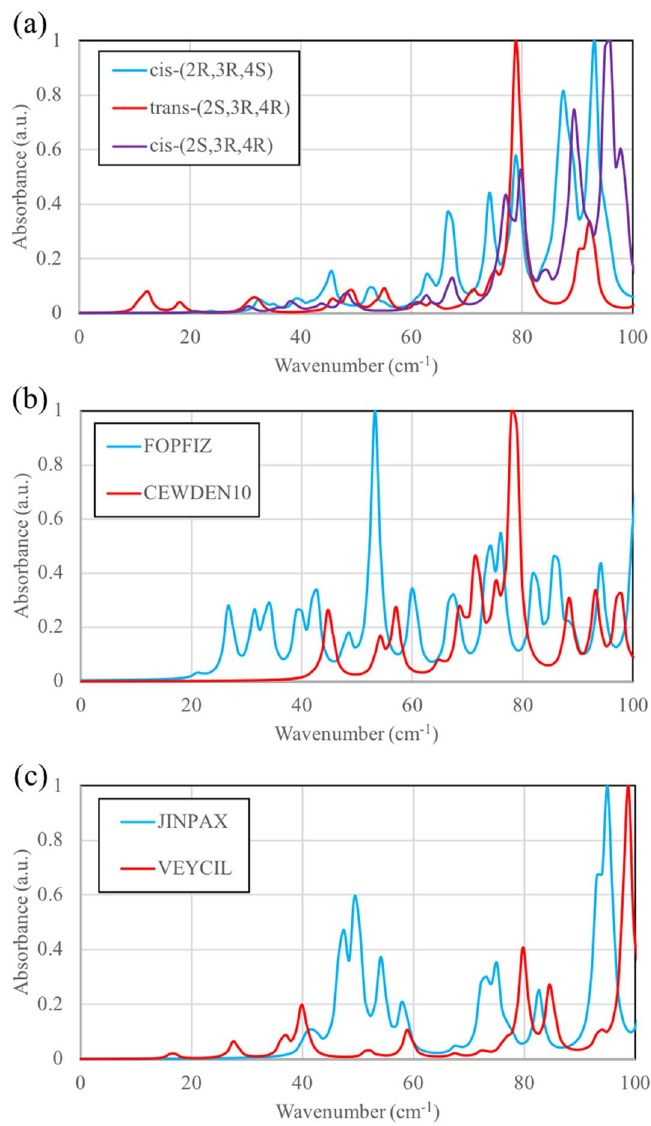
Figure 5. THz spectra of stereoisomers ( a ) ohmefentanyl ( cis -( 2R , 3R , 4S ), trans -( 2S , 3R , 4S ), and cis -( 2S , 3R , 4R )), ( b ) FOPFIZ ( trans ) and CEWDEN10 ( cis ), and ( c ) JINPAX ( 2R , 5S ) and VEYCIL ( 2S , 5S